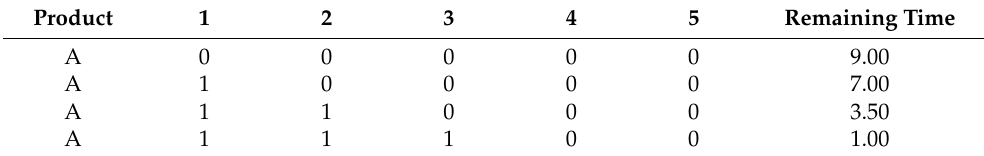
Table 3. Transformation of